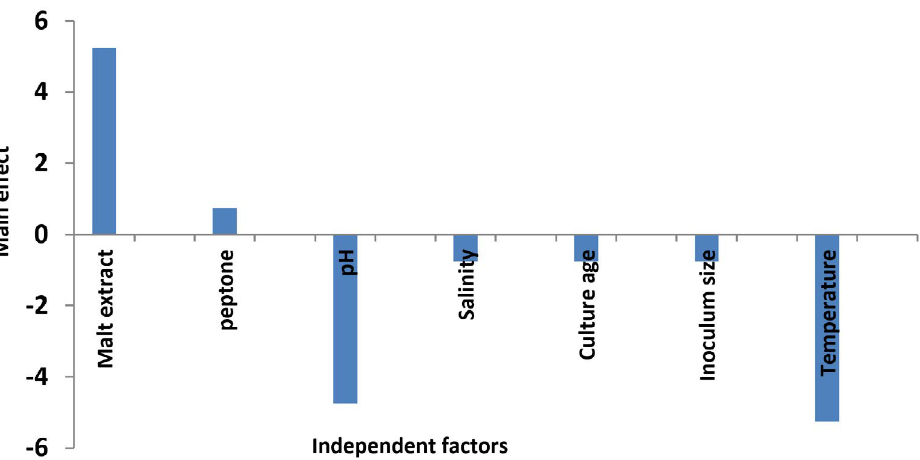
Fig. 4. Main effect of independent factors affecting antimicrobial agents production by Aspergillus terreus